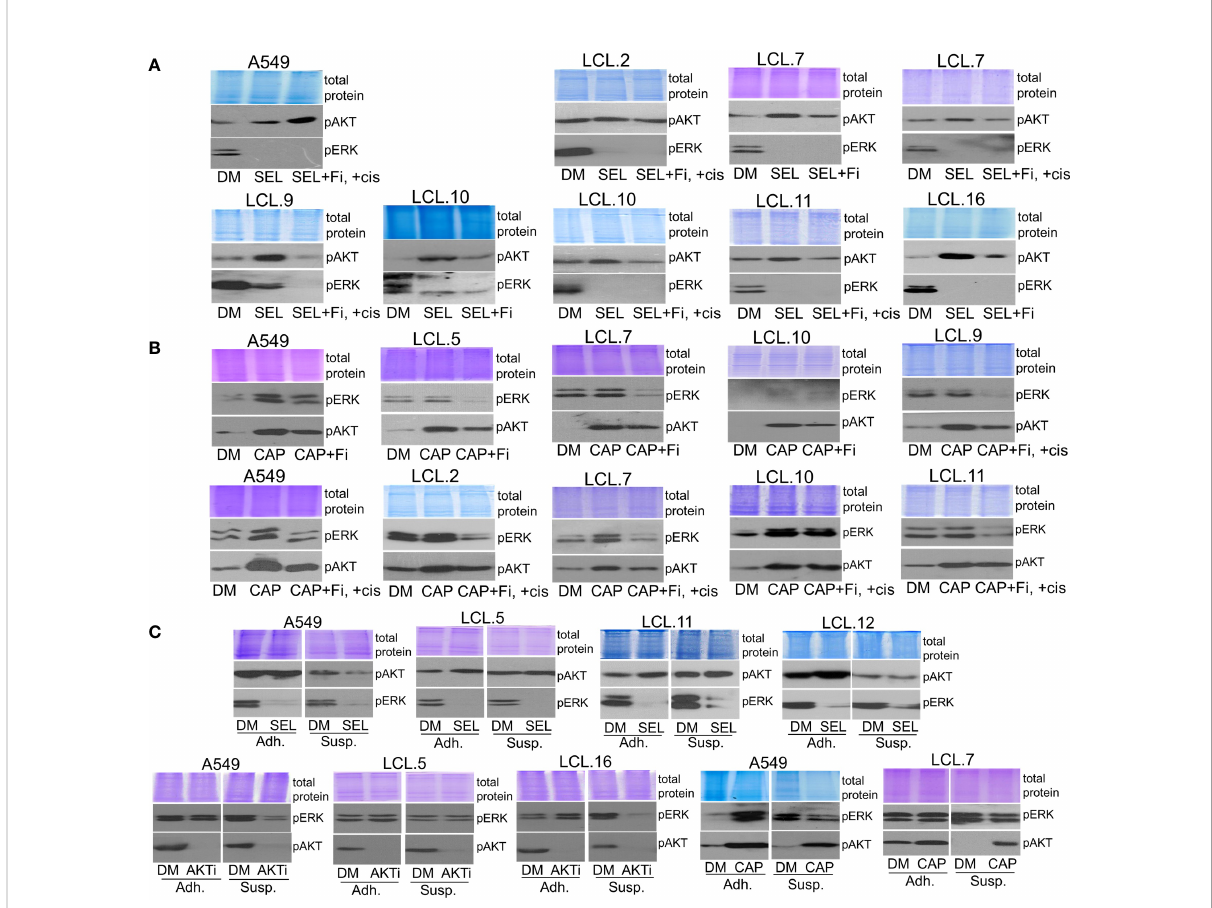
FIGURE 8 Dependence of the interplay between ERK and AKT signaling pathways on extracellular contacts. (A) Focal adhesion kinase inhibitor PF573228 (+Fi; 10 µM) attenuates the MEK kinase inhibitor selumetinib-induced increase of AKT phosphorylation in control and cisplatin-treated lung cancer-derived cells, except A549 cells. (B) PF573228 prevents the AKT inhibitor capivasertib-induced increase in ERK phosphorylation in control and cisplatin-treated lung cancer-derived cells. (C) Cells grown in suspension (Susp) under agitation, in contrast to adherent cells (Adh), do not show alternative kinase activation after the treatment with inhibitors. Representative Western blots are shown. Coomassie-stained protein gels are presented as loading controls. 6-hour-long exposures to the drugs were used. DM – vehicle control (DMSO), SEL – selumetinib (10 µM), +cis – cisplatin (90 µM), CAP – capivasertib (10 µM), AKTi – AKT inhibitor VIII (10